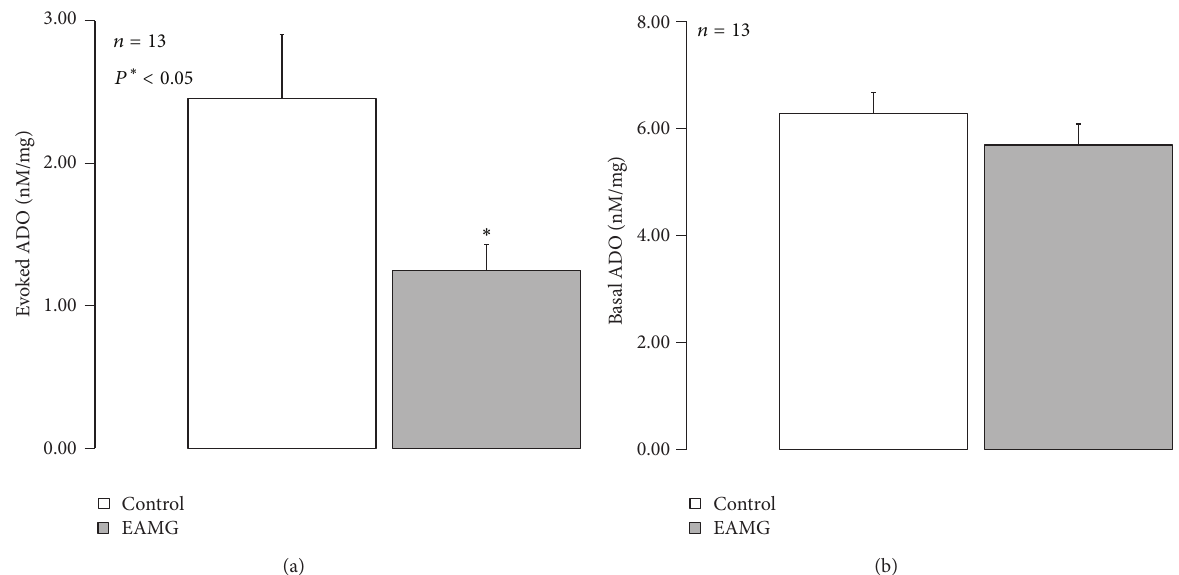
Figure 5: The amount ADO released upon phrenic nerve stimulation is lower in EAMG animals. The ordinates represent the (a) evoked release of ADO upon phrenic nerve trunk electrical stimulation (750 pulses applied at 5 Hz frequency) and (b) basal ADO quantified by HPLC(diode array detection). Nerve-evoked release of ADO was calculated by subtracting the basal release, measured in the sample collected before stimulation, from the total release of adenosine determined after stimulus application. The data are means ± S.E.M. of 13 animals of each group (na¨ıve, control, and